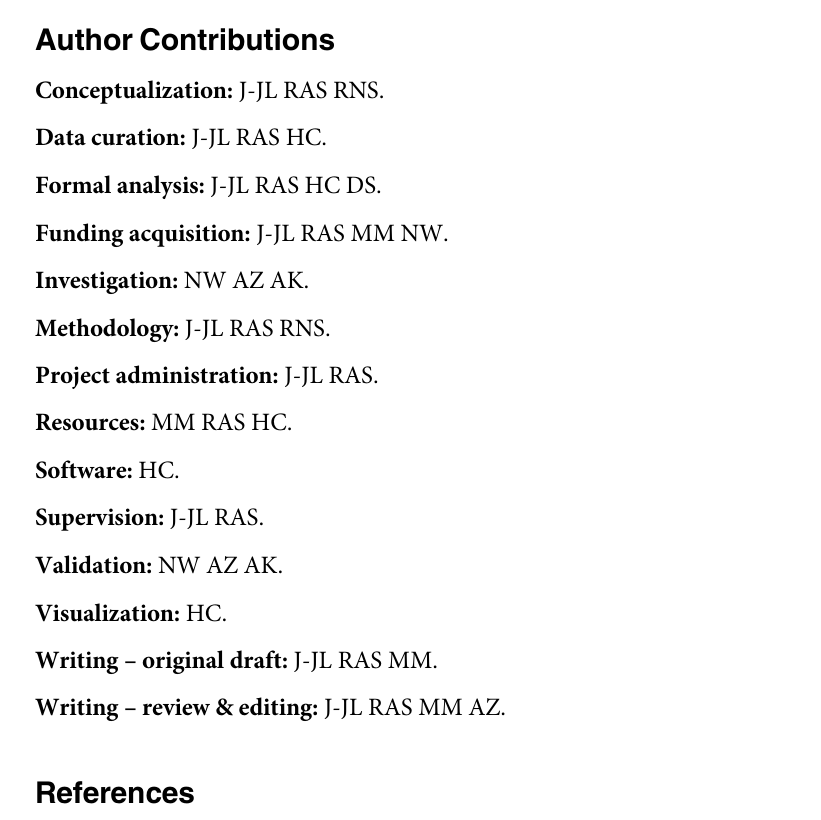
S2 Fig. A dendrogram generated by unweighted neighbor-joining method using genetic distance matrix based on SNP genotypic data, showing the relationship among all geno- typed individual trees. Data in the phylogenetic dendrogram were drawn to scale with the branch length proportional to the genetic dissimilarity. (TIF) S3 Fig. Association of principal components (PC-1 and PC-2) with geographic origins of the seed families. Genetic variations of 124 seed families were calculated by Principal Compo- nent Analysis based on genotypic data of 71 SNP loci. Above: PC-1 vs. latitude; Bottom: PC-2 vs. longitude.